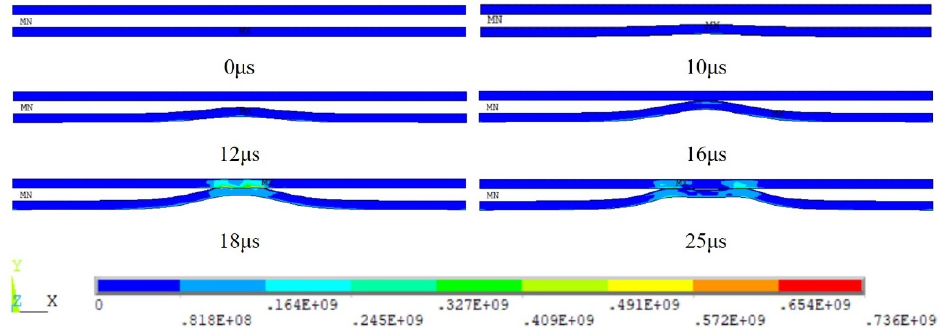
Figure 15. The von Mises stress distribution at typical time during collision. Figure 16a is a schematic diagram of typical nodes in Al-Mg MPW at a certain mo- ment. The 97# node is the center point of the model, the 86# node is the welding zone and